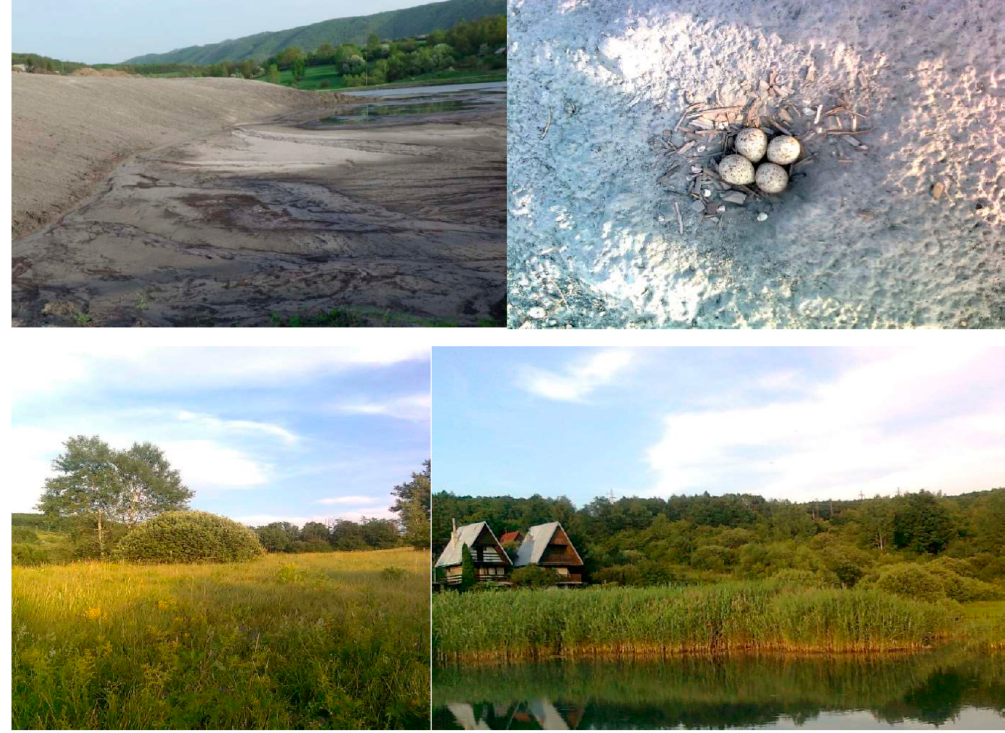
Figure 2. The sampling area around the ash pond ( left above ): MOS (ash sediment) and MOD (forming Technosol), ( right above ), the eggs of Charadrius dubius in the technogenic sediment of the pond’s dam, ( left below ) MOM (meadow), ( right below ) MOF (forest).